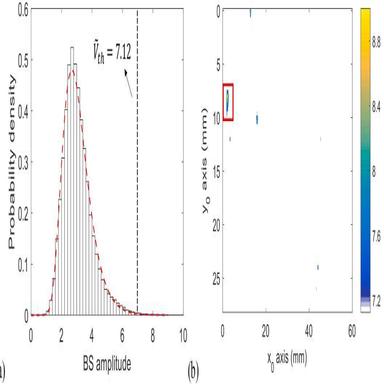
Statistical BS intensity obtained from the F = 12mm plane. (a) The histogram of the BS intensity and the fitted log-normal distribution in red dash line, and (b) the segmented image result by a statistical threshold, Ṽth. (For interpretation of the references to colour in this figure legend, the reader is referred to the web version of this article.)